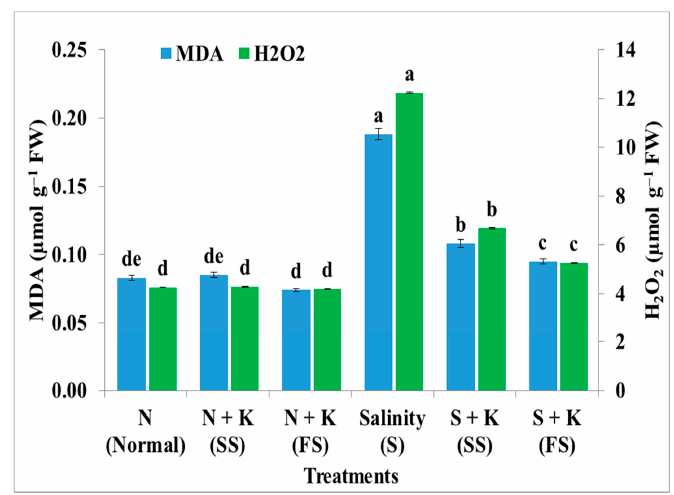
Figure 5. Effect of seed soaking (SS) and foliar spray (FS) of potassium (6 mM K 2 SO 4 ) on lipid peroxidation (measured as malondialdehyde (MDA) content) and hydrogen peroxide (H 2 O 2 ) content of soybean plants grown under normal (EC = 2.68 dS m − 1 ) and salt stress (EC = 7.46 dS m − 1 ) conditions. Means followed by the same letter in each parameter are not significantly different according to the LSD test ( p ≤ 0.05). Error bars are ± Standard Error (SE). Agronomy 2020 , 10 , x FOR PEER REVIEW